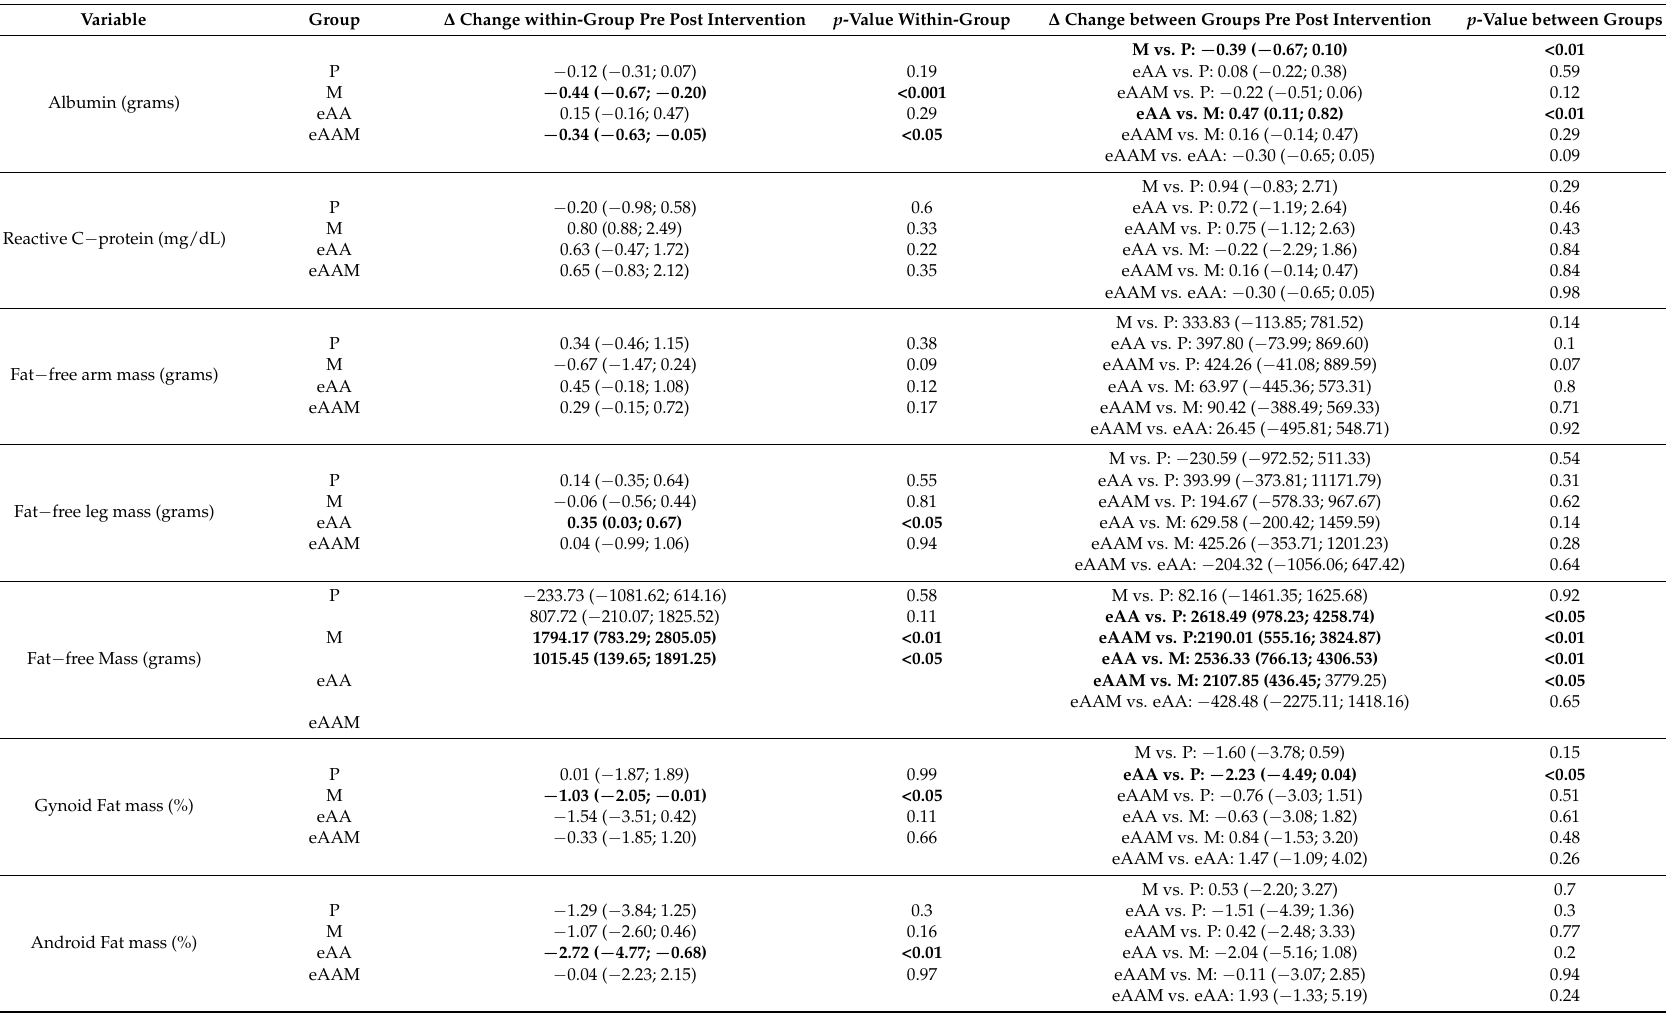
Table 2. Effects of the interventions, within and between groups, on inflammation markers, body composition and strength. Variable Group ∆ Change within-Group Pre Post Intervention p -Value Within-Group ∆ Change between Groups Pre Post Intervention p -Value between